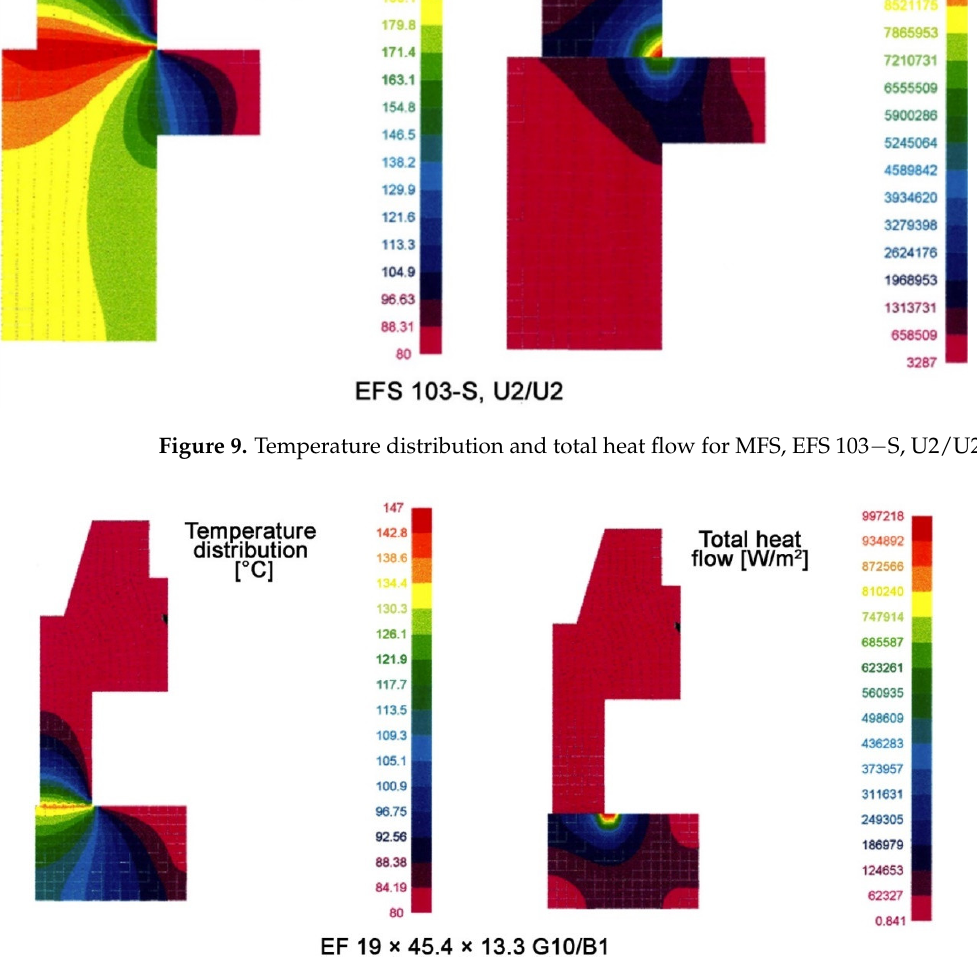
Figure 10. Temperature distribution and total heat flow for MFS , EF 19 × 45 , G10/B1.